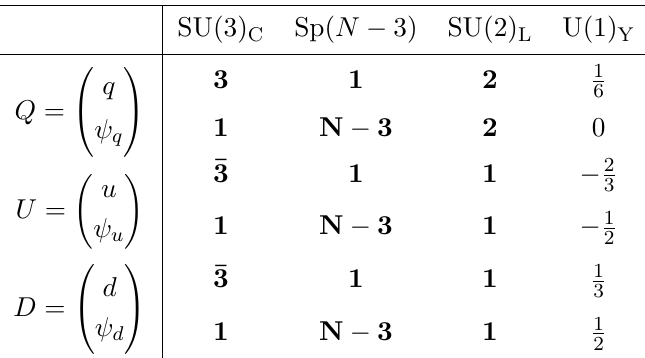
Table 2 . Decomposition of the quarks below the scale f GC . Here ψ q = ( ψ q doublet. The SM hypercharge U(1) Y is the sum of U(1)